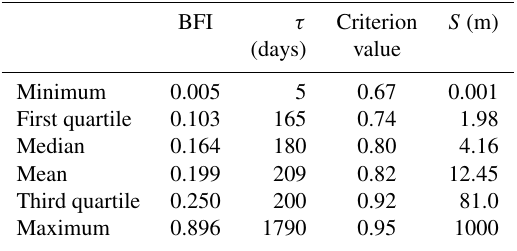
Table 4. Summary of the results from the set of 1664